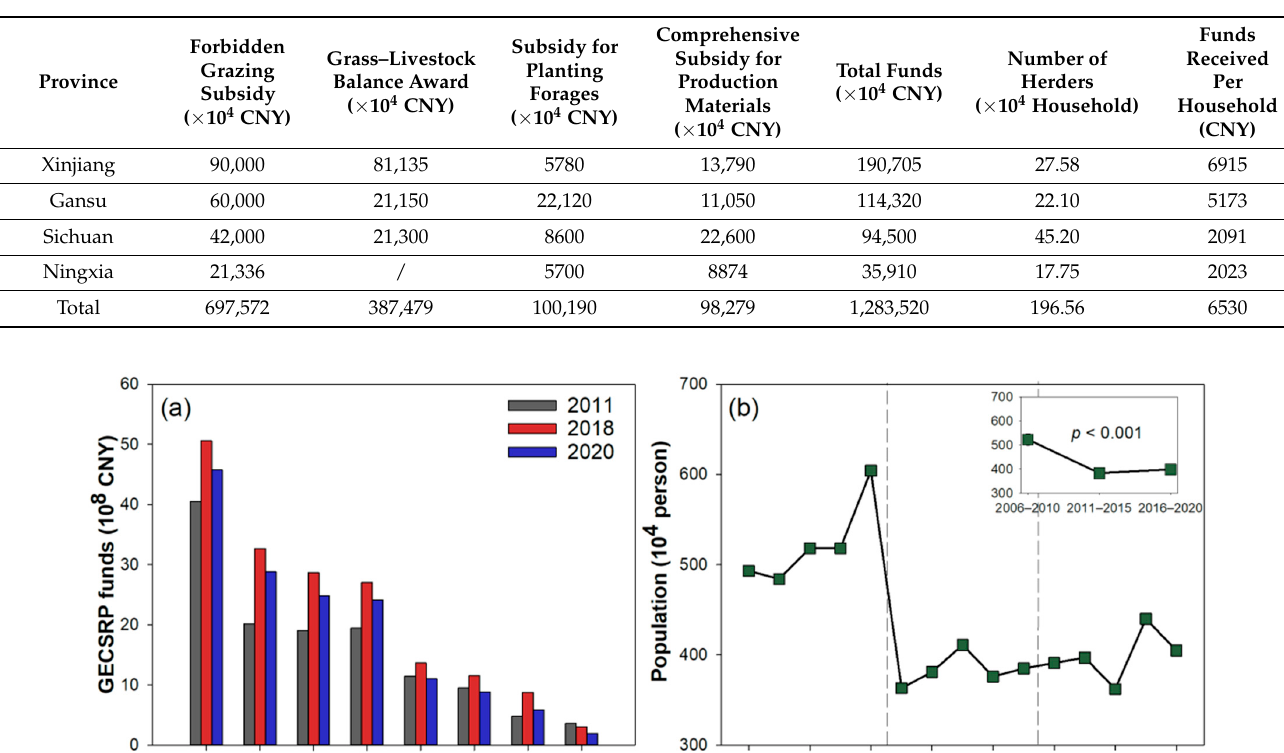
Table 2. GECSRP funding arrangements and amount received per household in 2011.